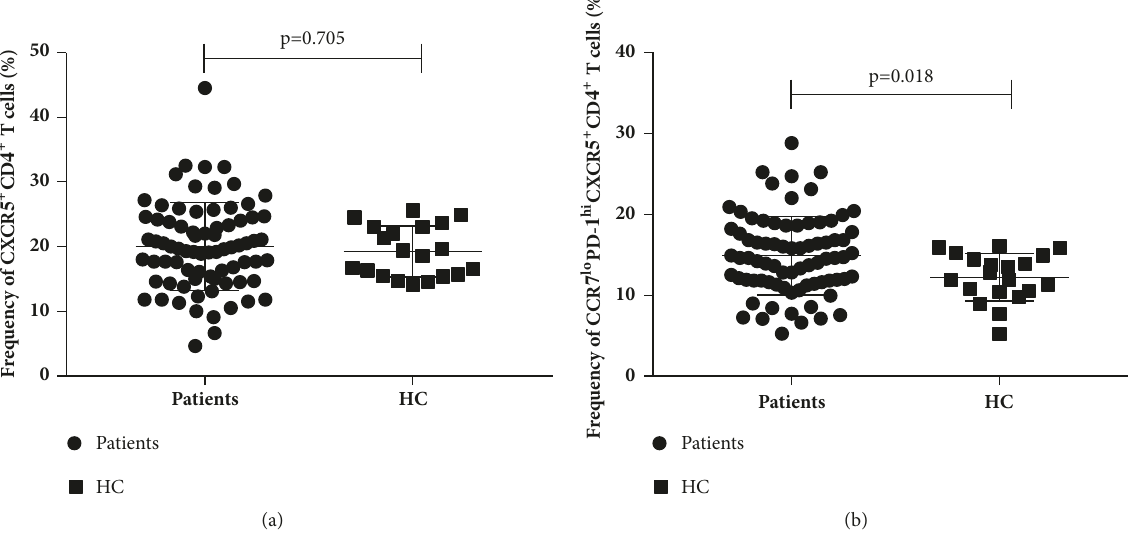
Figure 2: Frequencies of CXCR5 + CD4 + T cells and CCR 7 lo PD- 1 hi CXCR5 + CD4 + T cells in chronic HBV patients (n=77) and healthy controls (n=20). (a) Frequency of CXCR5 + CD4 + among all CD4 + CD3 + cells. (b) Frequency of CCR 7 lo PD- 1 hi CXCR5 + CD4 + among all CXCR5 + CD4 + CD3 + cells. Horizontal lines show the median.